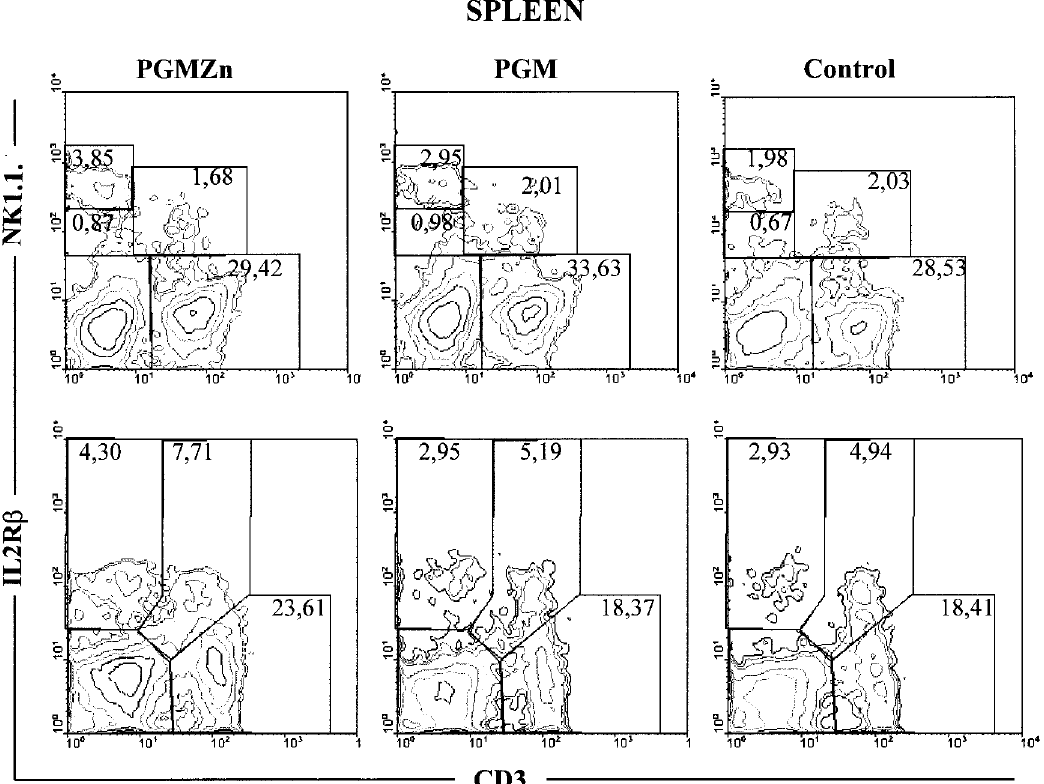
FIG. 3. FACS profiles of two-color immunofluorescence staining of splenic MNLC after in vivo treatment with PGM-Zn, PGM or medium, shown as a representative result of three isolated